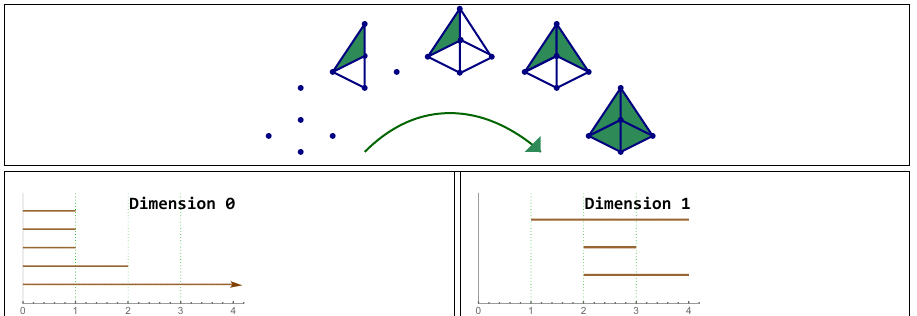
Figure 4. Top : example of a filtration K . Bottom : barcodes representing connected components and cycles. Note there is a [ 0, ∞ ) bar in the 0 dimensional persistent homology. In this example: = 3, β 1 = 1, β 1 = 2, β 1 = 1 and then [ 2,3 ) appears once in the 1-dimensional β 1 2,2 2,3 1,2 1,3